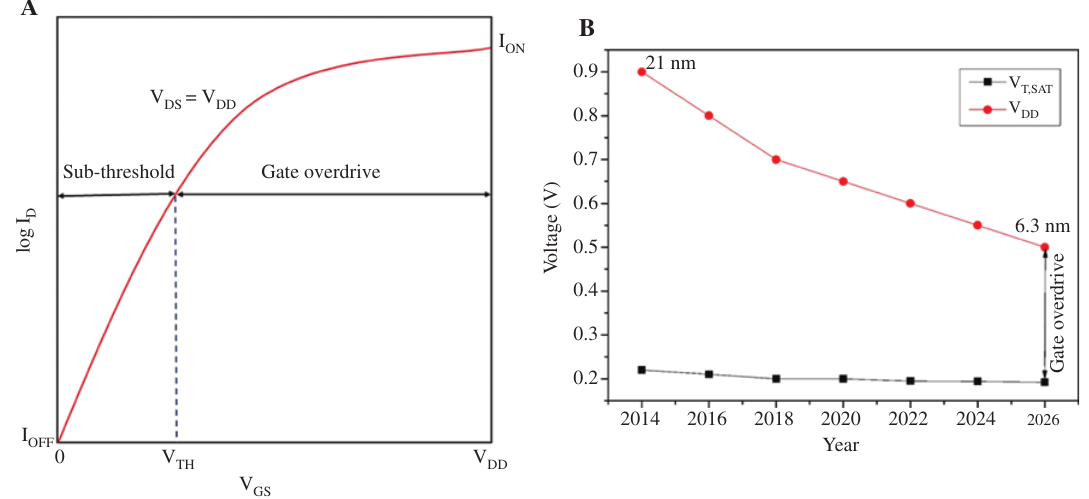
-V . (B) ITRS specification for supply voltage (V D GS is the threshold voltage at V T,SAT